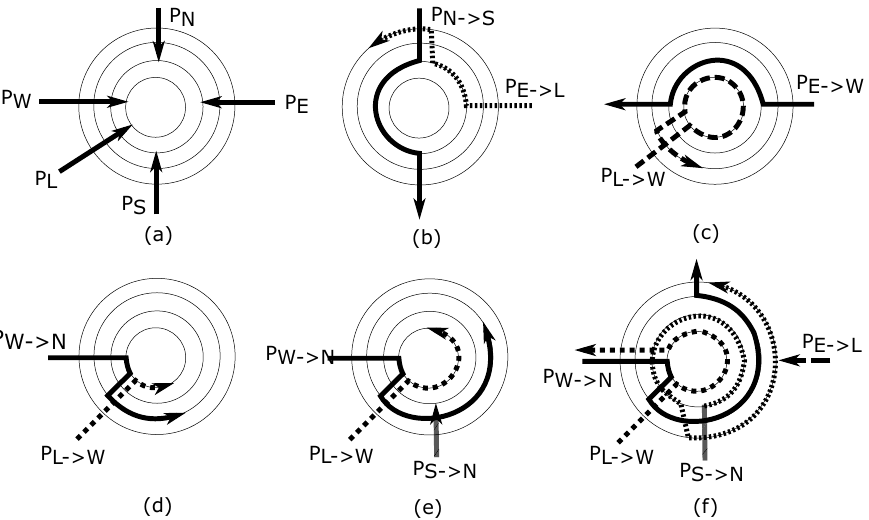
Figure 2. Packet flow scenarios in deadlock-free R-NoC : ( a ) Packet entry ( b ) Lane switching caused by blocked path ( c ) Lane switching when packet output port is busy. P X → Y : a packet from X input port and destined for Y output port. ( d ) Low traffic: a packet from the west switches lane and uses secondary lane resources. ( e , f ) More lane resources are being